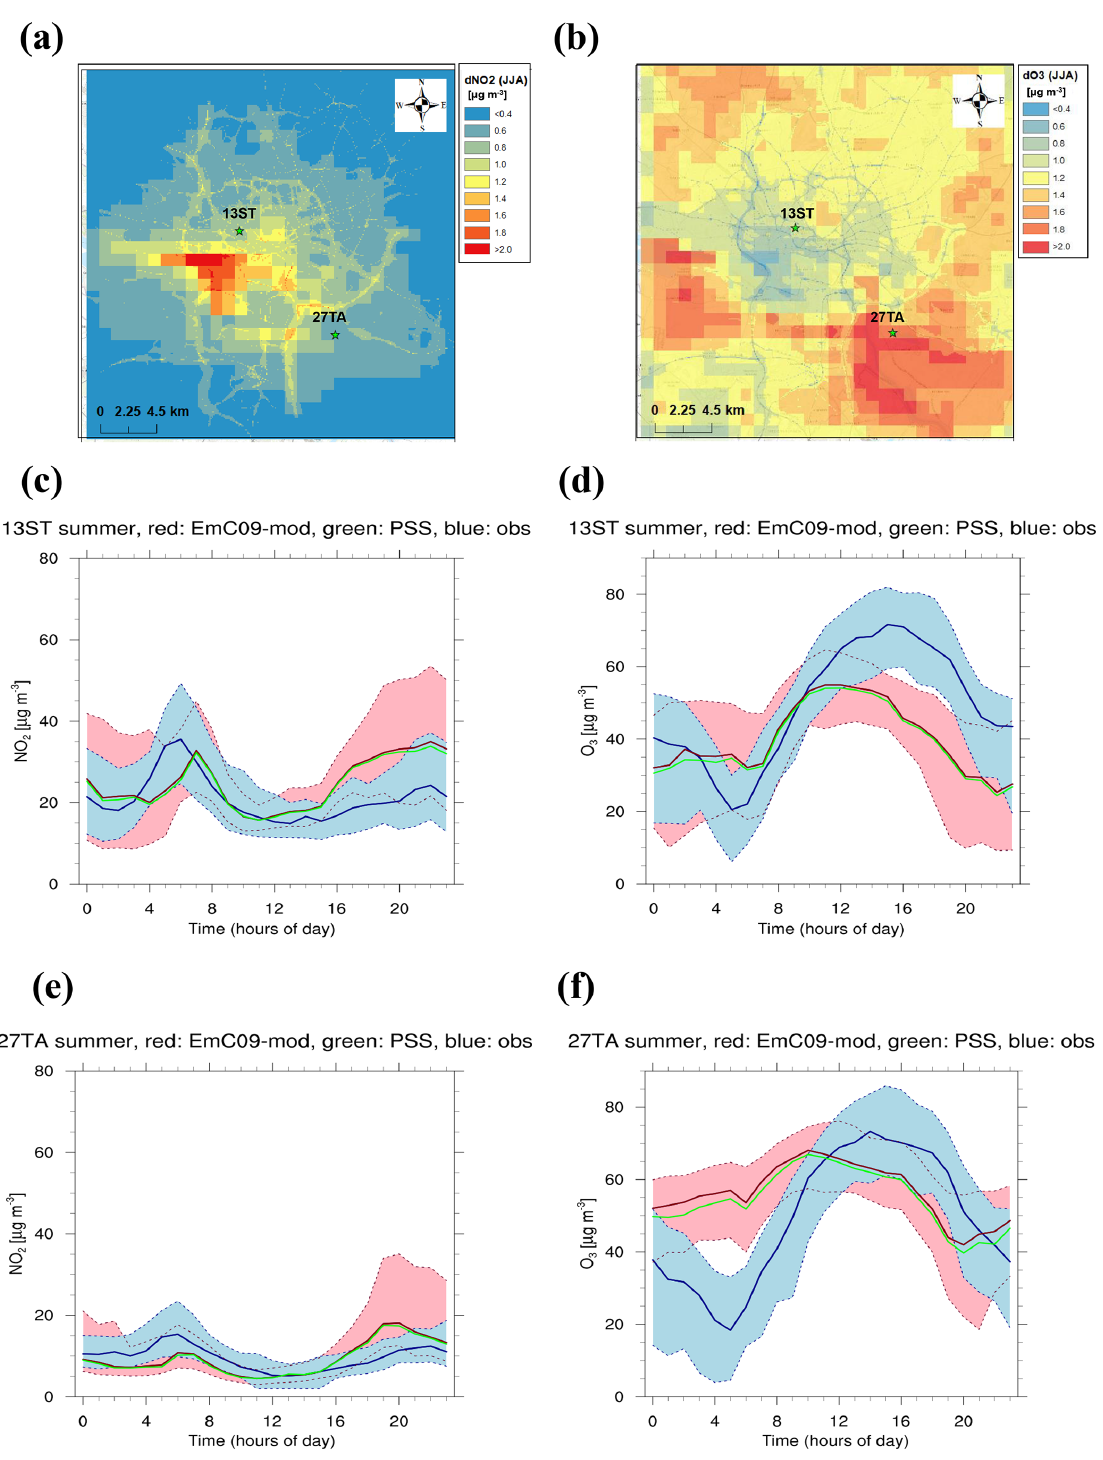
Figure 10. Comparison of ozone formation in summer (JJA) with EmChem09-mod (short: EmC09-mod) to the PSS assumption using EPISODE–CityChem in Hamburg: (a) summer mean NO 2 concentration difference between a simulation with EmC09-mod and with PSS, (b) summer mean O 3 concentration difference between a simulation with EmC09-mod and with PSS, (c) diurnal cycle of summer NO 2 at station 13ST, (d) diurnal cycle of summer O 3 at station 13ST, (e) diurnal cycle of summer NO 2 at station 27TA, (f) diurnal cycle of summer O 3 at station 27TA. Modelled median shown as a red line for EmChem09-mod and as a green line for PSS; the observed median is shown as a blue line. Shaded area reflects the bandwidth between the 25th percentile and the 75th percentile (EmChem09-mod, red shaded; observation, blue shaded). Green stars in panels (a) and (b) indicate the locations of stations 13ST and